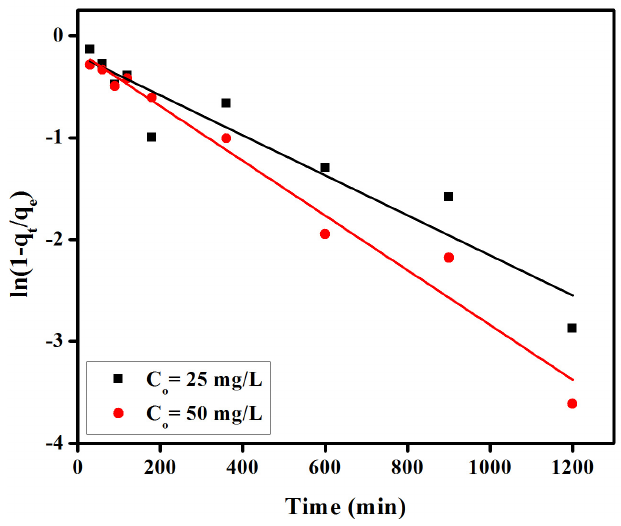
Figure 8. Liquid film diffusion model for adsorption of congo red on anion exchange membrane